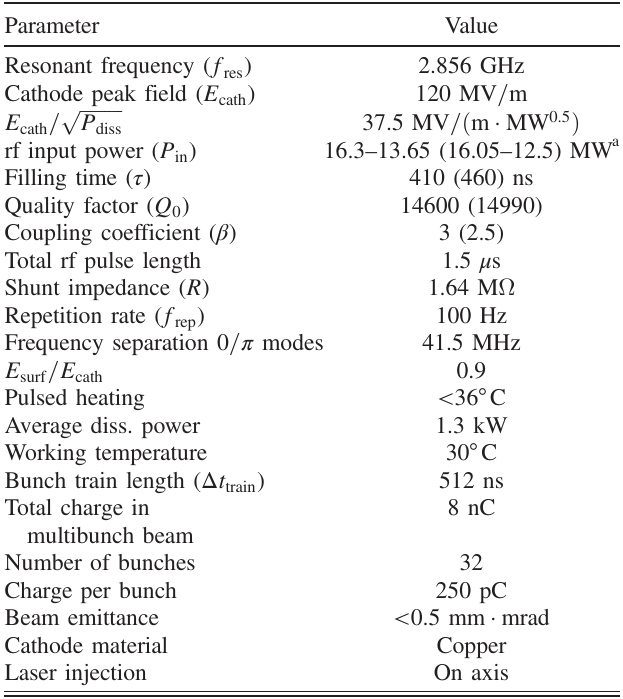
TABLE I. Parameters of the ELI-NP rf gun (in parentheses, the measured values if different from the nominal